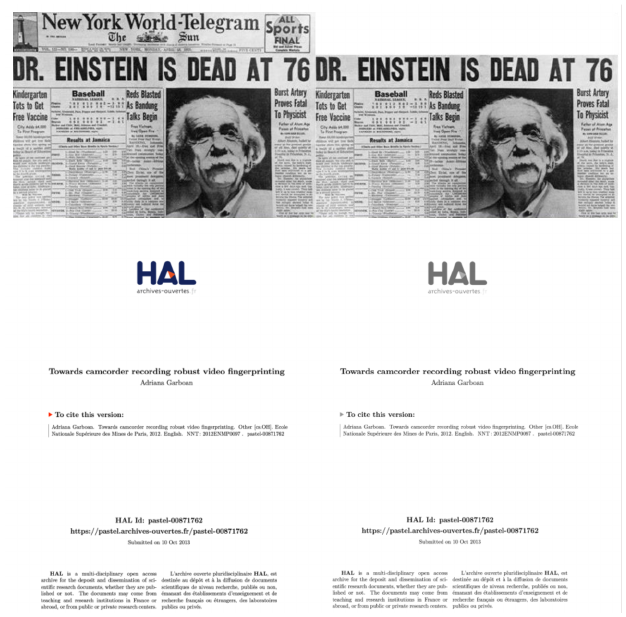
Figure 1. Digital documents: heterogeneous content (text, image, etc.) with various digital represen- tations for the same semantic